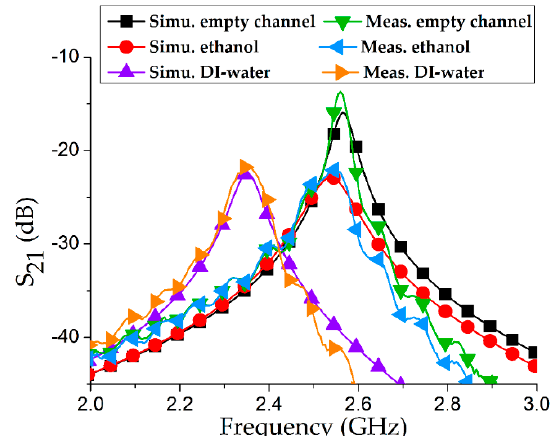
Figure 9. Simulations and measurements of insertion loss (magnitude of S 21 ) obtained from our proposed microwave resonator when an empty channel, ethanol, and DIW were analyzed. Table 2. Comparison of simulations and measurements. The resonant frequency ( f r ), Q-factor, and insertion loss (IL) for the three cases (air, ethanol, and DIW) are presented.